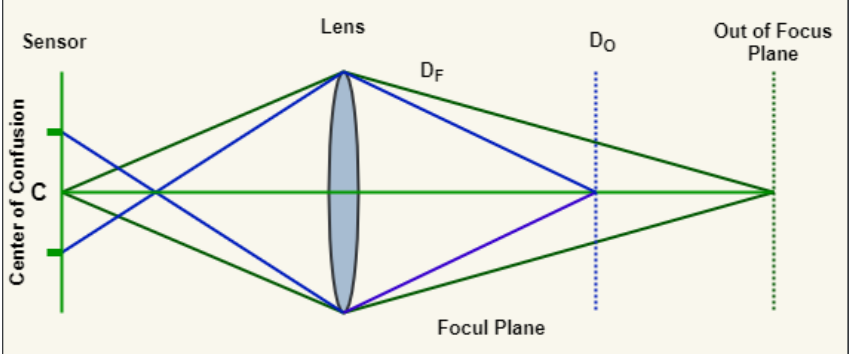
Figure 1. Circle of Confusion in focal and out of focus